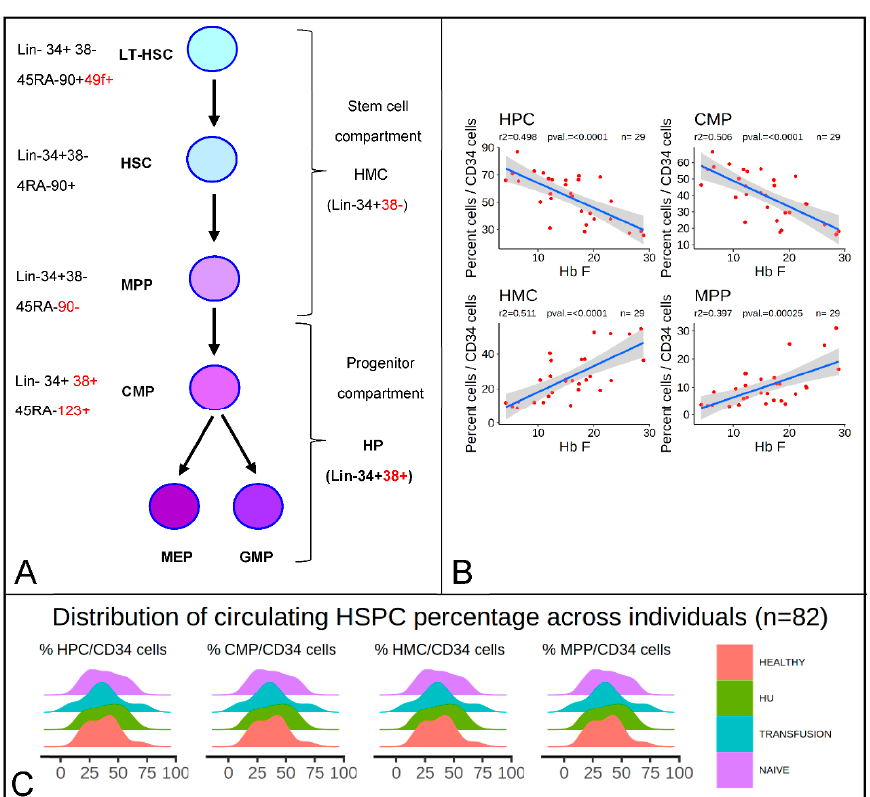
Figure 1. HbF levels are inversely proportional to the percentage of hematopoietic progenitors cells (HPCs), and common myeloid progenitors (CMPs) and proportional to the percentage of hematopoietic multipotent cells (HMCs) and multipotent progenitors (MPPs) in sickle cell disease (SCD) patients treated with hydroxyurea (HU). ( A ) Diagram illustrating the hematopoietic stem and progenitor hierarchy and the antigens used to define each subpopulation of hematopoietic stem and progenitor cell (HSPCs). ( B ) Regression analysis of the percentage of HbF as a function of the percentage of HPCs, CMPs, HMCs, and MPPs/CD34 bright . Linear regression line is represented in blue. ( r 2 and F-statistic p -values are provided above). Grey smooth represents the 95% confidence interval. The percentage HbF is negatively correlated with the percentage of HPC/CD34 cells and positively correlated with the proportion of HMC/CD34. ( C ) Ridgeline density plots illustrating the broad distribution of the percentages of HMCs, HPCs, MPPs, and CMP / CD34 bright in controls and in SCD patients that are treatment-naïve, treated with HU, or treated with transfusion ( n =